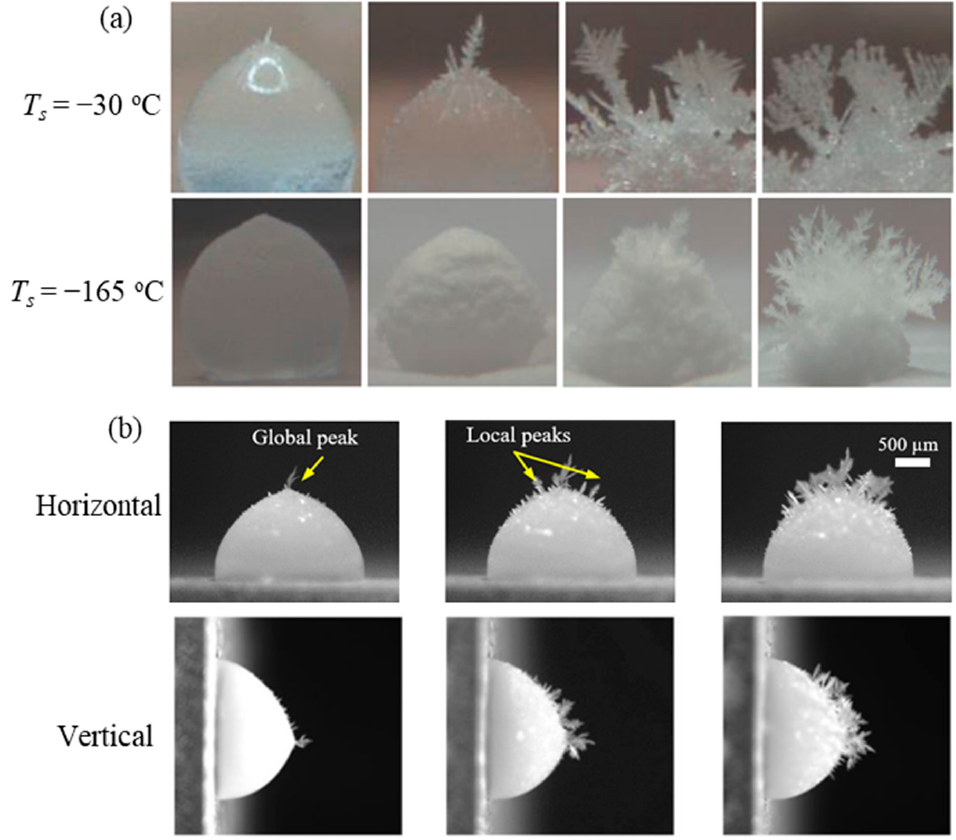
Figure 4. Growth dynamics of ice dendrites atop a frozen drop. ( a ) at an ordinary-low temperature of − 30 ◦ C or a cryogenic temperature of − 165 ◦ C, Reprint from [42], Copyright 2022 with permission from Elsevier. ( b ) placed horizontally or vertically, Reprint from [43], Copyright 2022 with permission from MDPI.